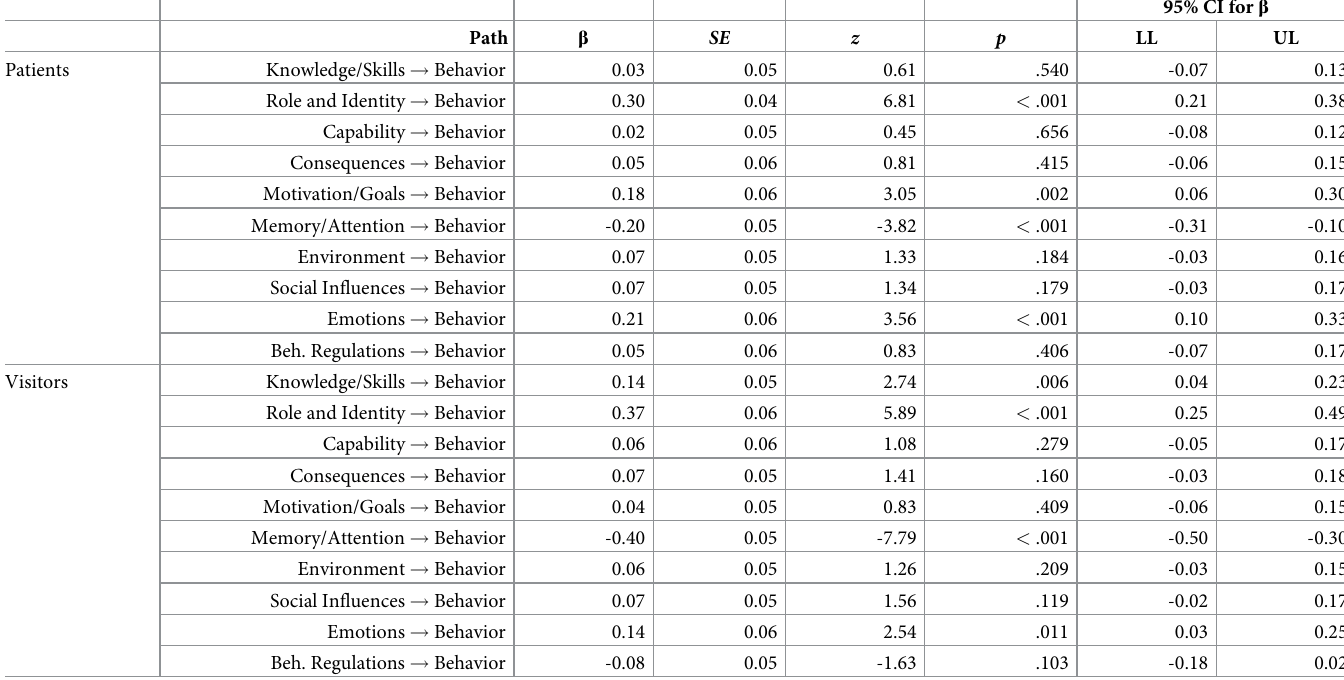
Table 3. Coefficients for the TDF path models.